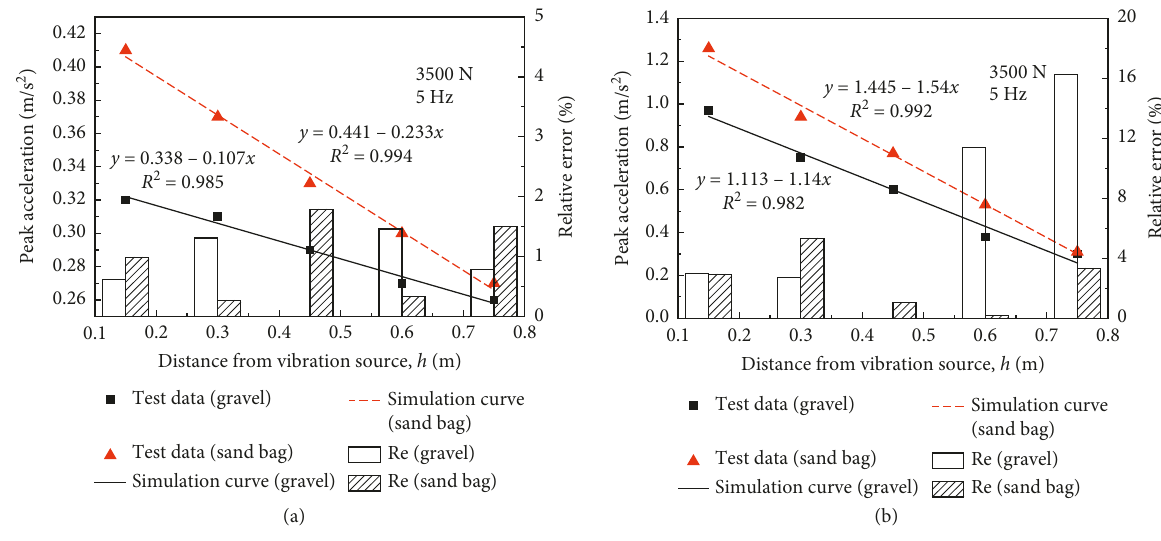
Figure 22: Acceleration test results and fitting formulae: (a) single jack and (b) three jacks. Table 7: Values of the fitting parameters under different conditions shown in Figure